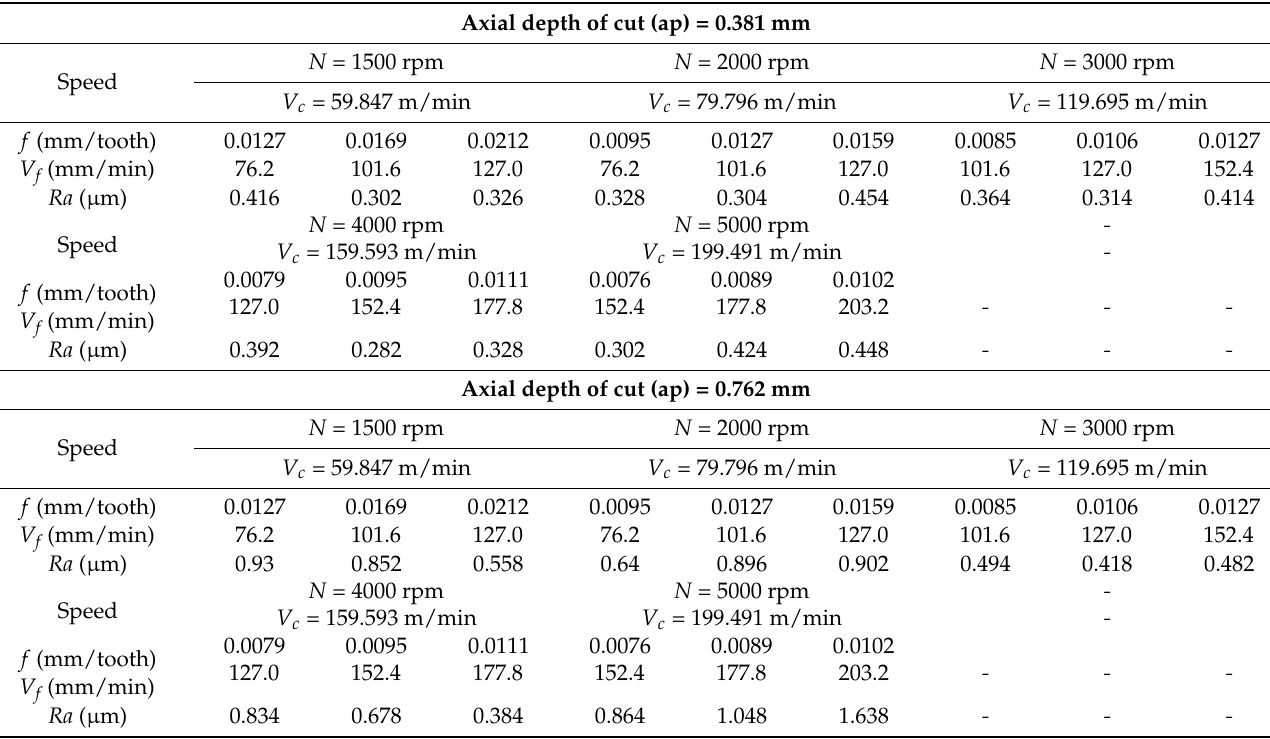
Table 1. Average surface roughness measures Ra for the steel milling